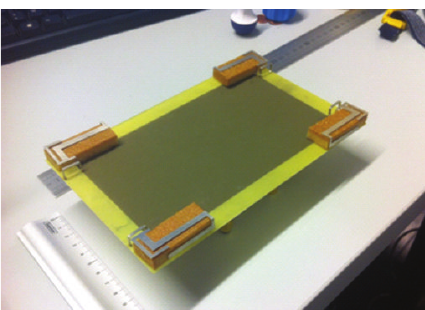
Figure 11: Antenna system prototype.